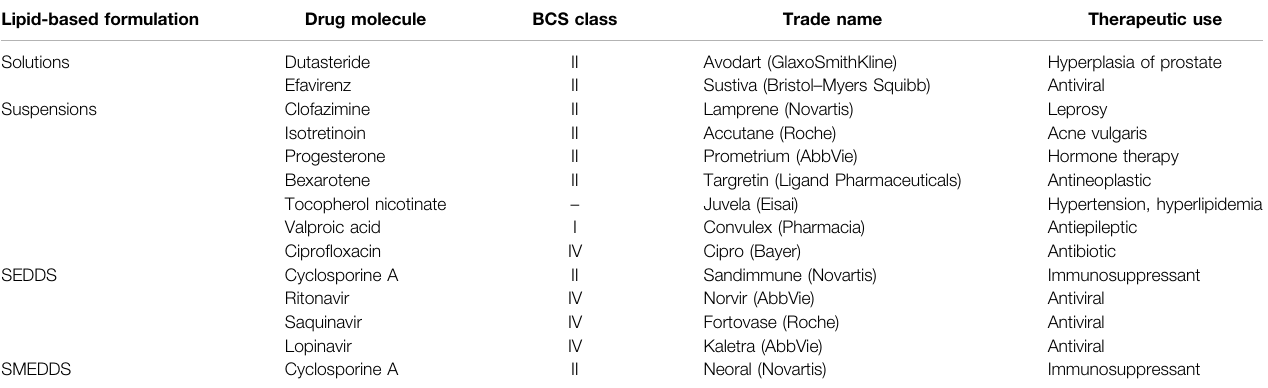
TABLE 8 | Representative examples of marketed oral lipid-based formulations. Lipid-based